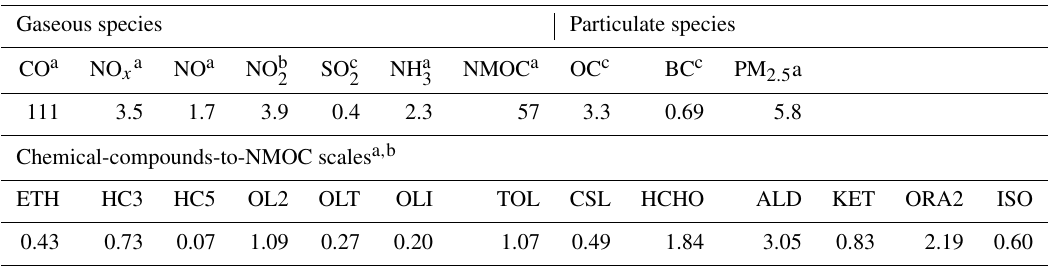
Table 2. The gaseous and particulate species emission factors (gkg − 1 ) and scales to convert NMOC emissions (kgday − 1 ) to WRF-CHEM chemical species (moles-speciesday − 1 ) from crop field burning. The detailed chemical species are described by Stockwell et al. (1990). Gaseous species